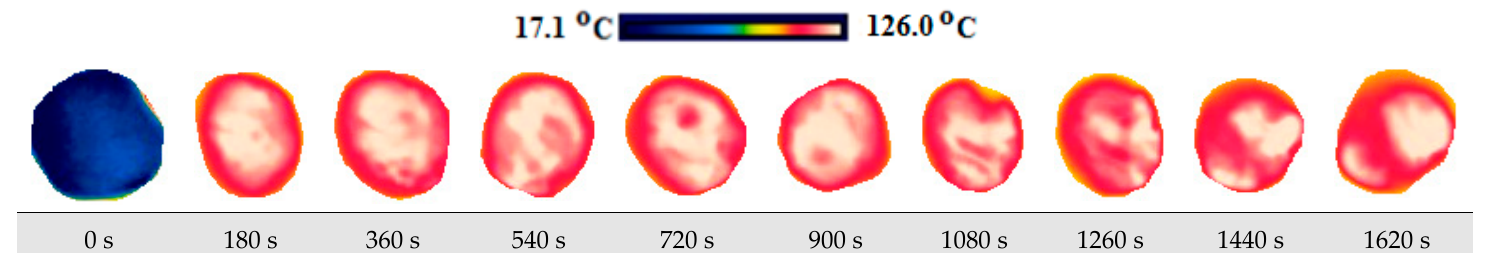
Figure 18. Thermal images of persimmon with 9 mm at 120 W.